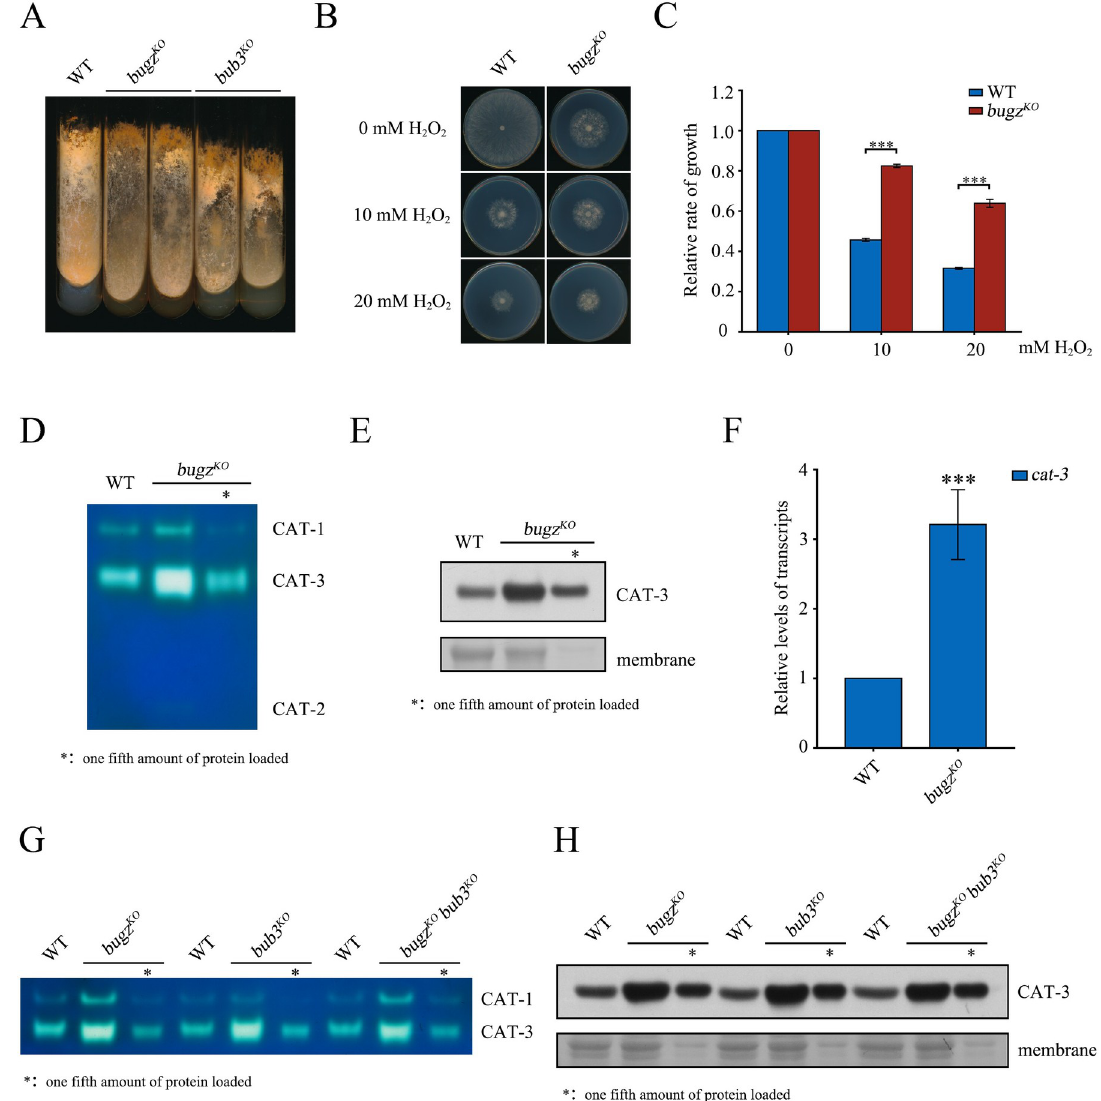
Fig 2. BuGZ and Bub3 function in the same pathway to repress cat-3 expression. (A) Aerial hyphae and conidia of WT, bugz KO , and bub3 KO strains on slants. Cultures were grown at 25˚C under constant light after 1 day at 30˚C. (B) Mycelial growth of WT and bugz KO strains on plates with 0, 10, or 20 mM H 2 O 2 . (C) Quantitation of growth of bugz KO strain relative to WT under conditions described in panel B. (D) In-gel catalase activity assays of protein extracts from WT and bugz KO strains. (E) Western blot analysis of CAT-3 protein in WT and bugz KO strains. The membranes stained by Coomassie blue served as the loading control. (F) Quantification of cat-3 mRNA in bugz KO strain relative to WT. (G) In-gel catalase activity assays of protein extracts from WT, bugz KO , bub3 KO , and bugz KO bub3 KO strains. (H) Western blot analysis of CAT-3 protein in WT, bugz KO , bub3 KO , and bugz KO bub3 KO strains. The membranes stained by Coomassie blue served as the loading control. Error bars indicate SD (n = 3). Significance was evaluated by two-tailed t -test. � P < 0.05, �� P < 0.01, and ��� P < 0.001. mutant BuGZ was considerably reduced compared to the Myc-tagged wild-type BuGZ; how- ever, deletion of the entire GLEBS domain resulted in higher levels of BuGZ (Fig 3D). We next generated a series of strains with deletion of different segments inside the GLEBS domain of BuGZ (Fig 3C). The interaction between Myc-BuGZ Δ G1 and Bub3 was weakened compared to that between the Myc-tagged wild-type BuGZ and Bub3, while the lack of all other segments